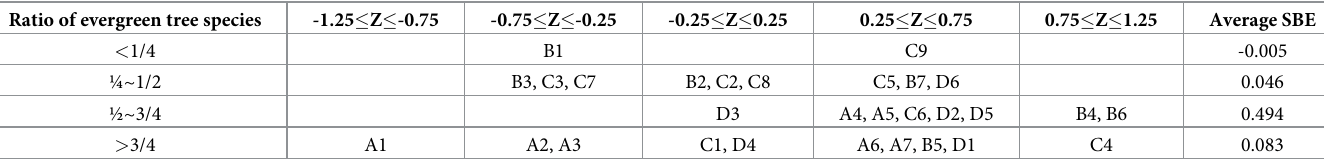
Table 6. SBE scores of samples based on the ratio of evergreen tree species.